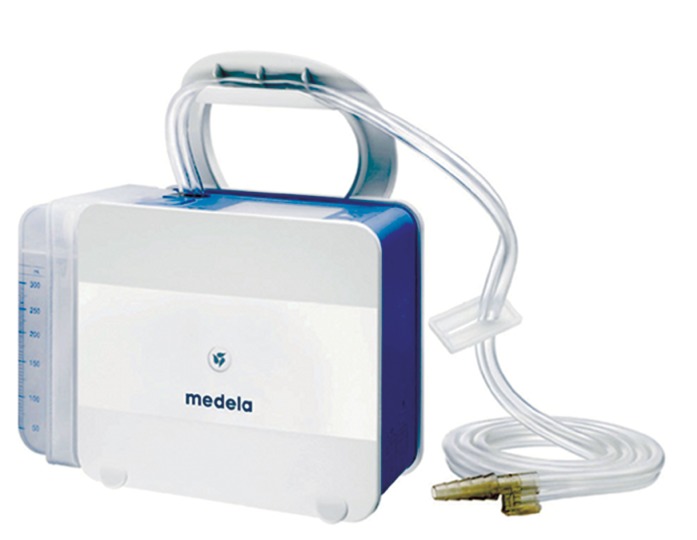
Sistema digital para drenagem torácica.